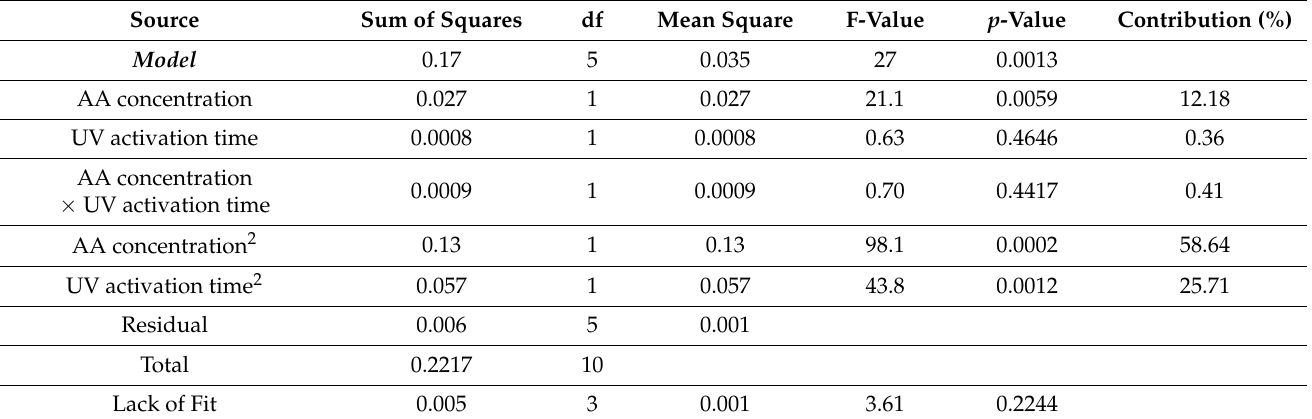
Table 5. ANOVA analysis for the permeability